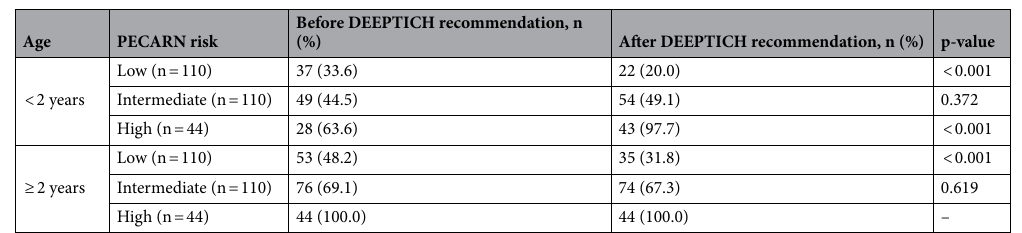
Table 4. Ordering a head CT decision result according to risk of cases.